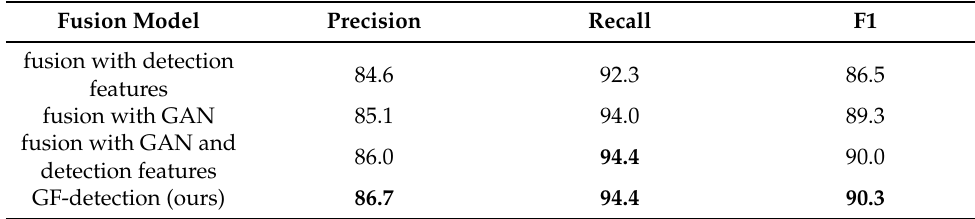
Table 3. Comparison results of four fusion models with IoU set as